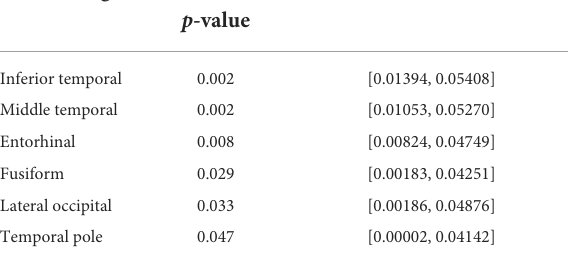
TABLE 3 Cortical regions in the left hemisphere with corresponding bootstrap-obtained p -values and non-adjusted 95% confidence intervals (for geodesic